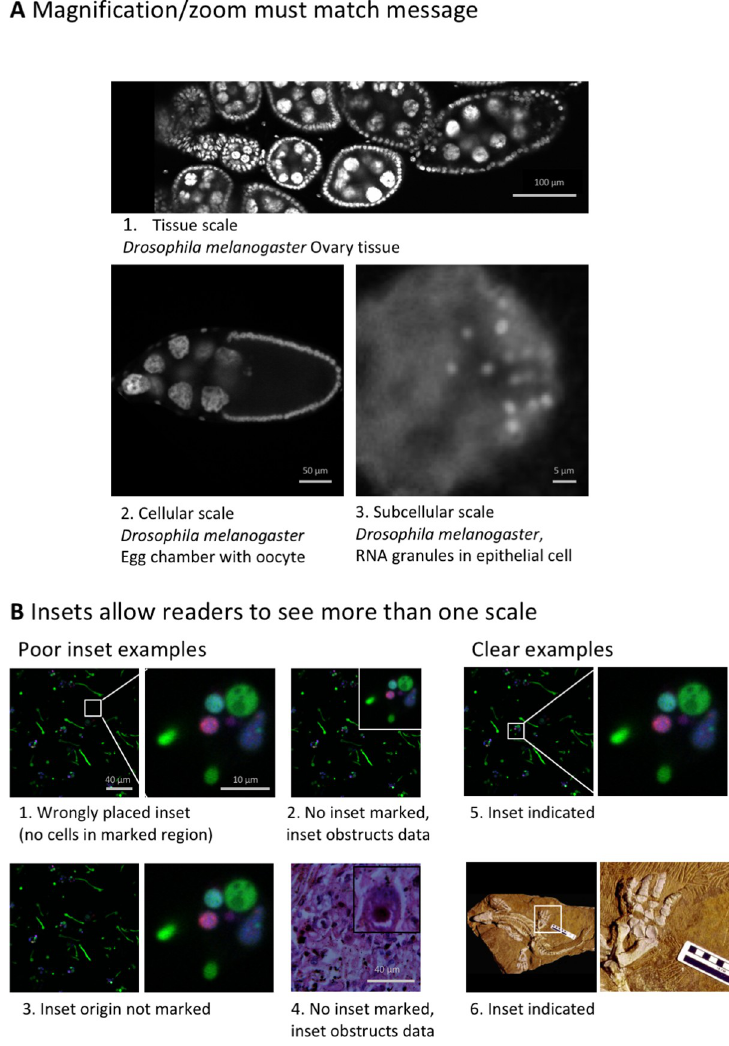
Fig 3. Selecting magnification and using insets. (A) Magnification and display detail of images should permit readers to see features related to the main message that the image is intended to convey. This may be the organism, tissue, cell, or a subcellular level. Microscope images [18] show D . melanogaster ovary (A1), ovarian egg chamber cells (A2), and a detail in egg chamber cell nuclei (A3). (B ) Insets or zoomed-in areas are useful when 2 different scales are needed to allow readers to see essential features. It is critical to indicate the origin of the inset in the full-scale image. Poor and clear examples are shown. Example images were created based on problems observed by reviewers. Images show B1, B2, B3, B5: Protostelium aurantium amoeba fed on germlings of Aspergillus fumigatus D141-GFP (green) fungal hyphae, dead fungal material stained with propidium iodide (red), and acidic compartments of amoeba marked with LysoTracker Blue DND-22 dye (blue); B4: Lendrum-stained human lung tissue (Haraszti, Public Health Image Library); B6: fossilized Orobates pabsti [19].